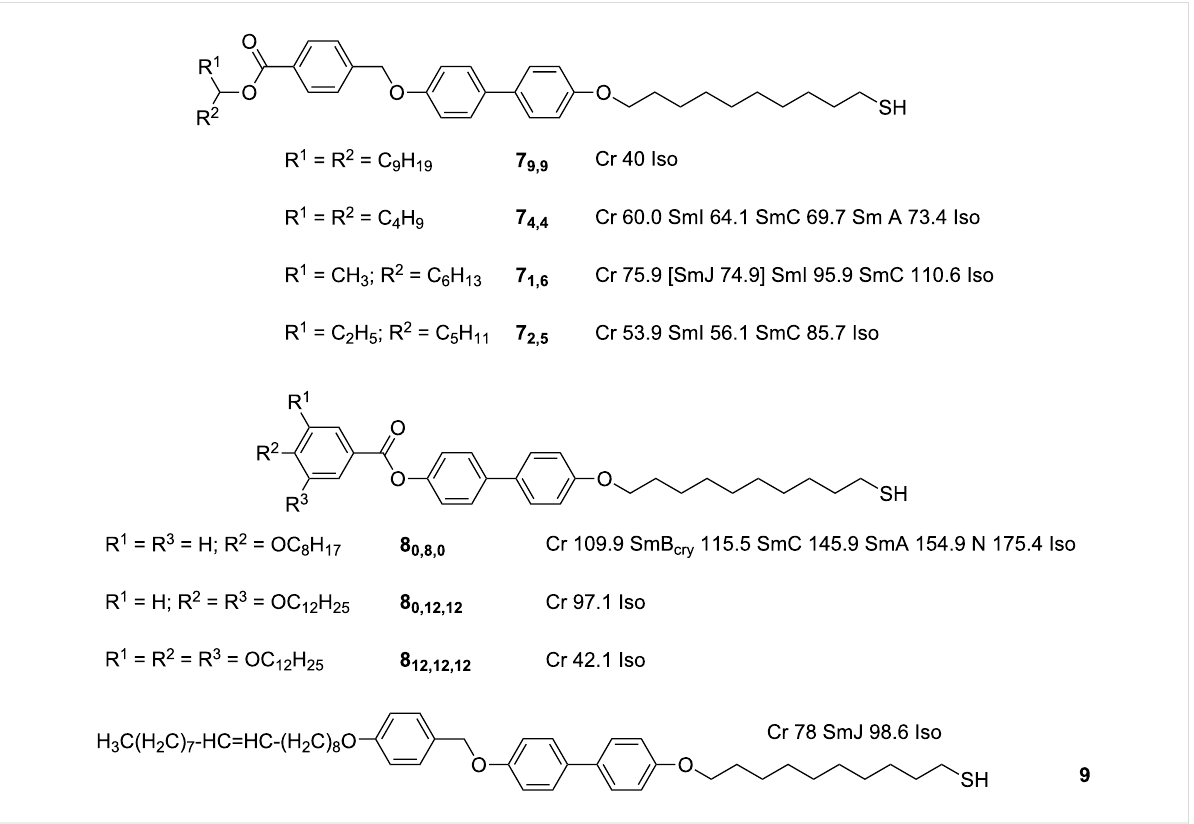
Figure 8: Chemical structures and LC properties of the rodlike ligands discussed in the text.